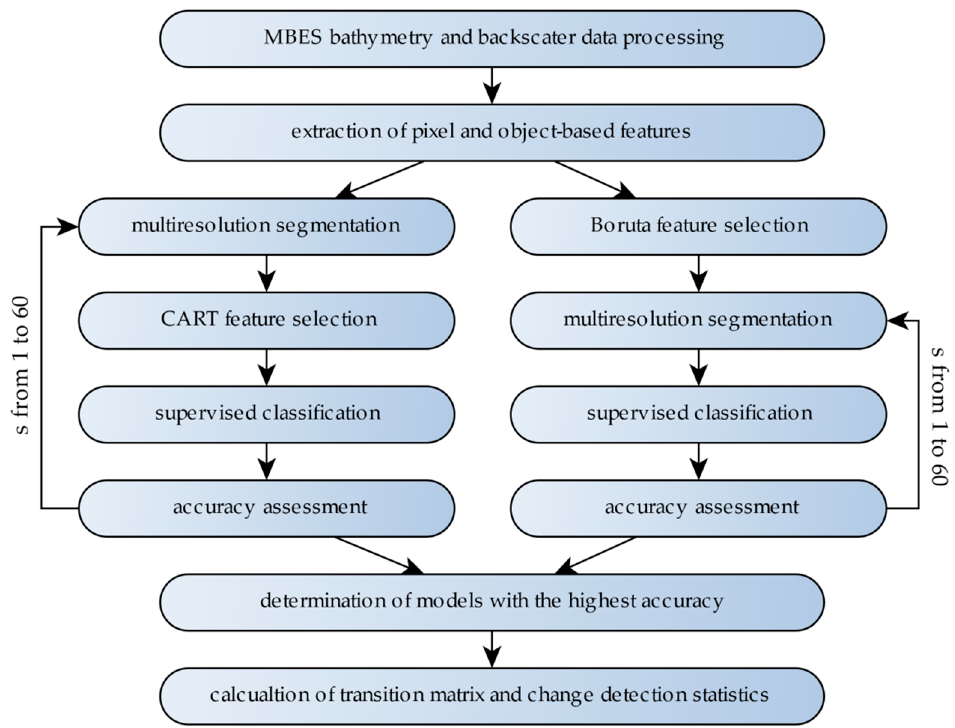
Figure 2. Sediment composition mapping and change detection workflow developed in this study. s—scale of multiresolution segmentation. MBES—multibeam echosounder; CART—classification and regression tree.